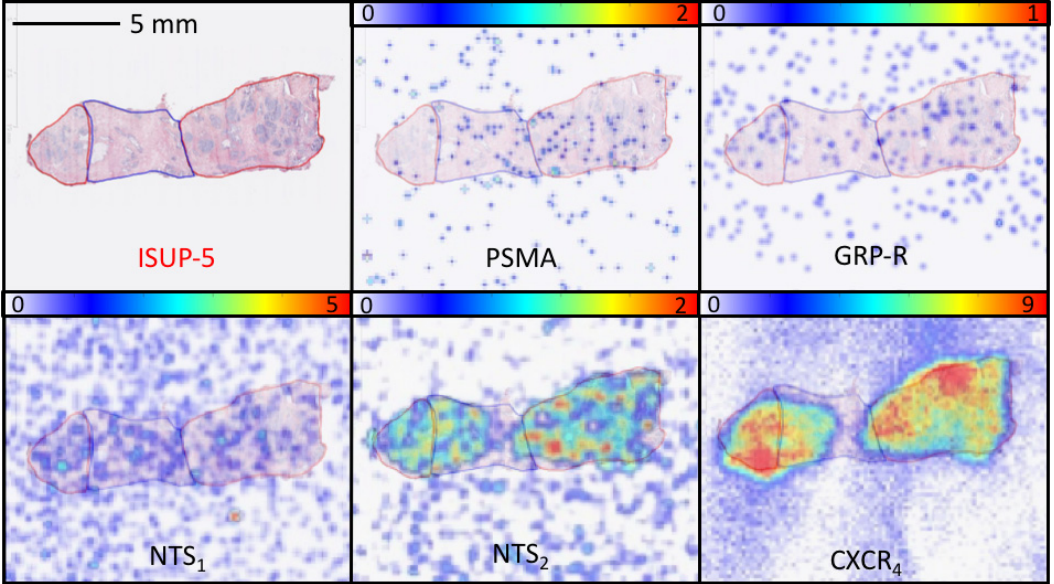
Figure 4. Comparison between PSMA, GRP-R, NTS 1 , NTS 2 and CXCR4-specific radiopharmaceuticals on an ISUP-5 sample. The red line drawing on HES slice corresponds to the tumor area. PSMA, GRP-R and NTS 1 samples showed no uptake on the tumoral area. Contrarily, NTS 2 , and CXCR4 showed a strong tumor uptake. Specific binding = 0% for PSMA, 0% for GRP-R, 0% for NTS 1 , 71% for NTS 2 and 100% for CXCR4. Color scale refers to cps/mm².